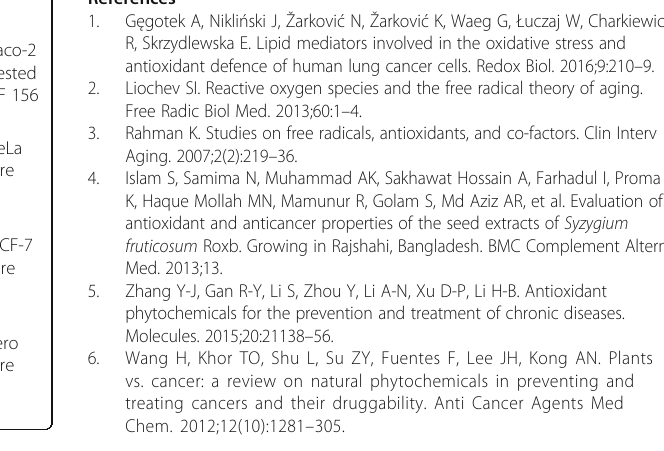
Additional file 1: Figure S1. Non-linear regression curves for IC 50 de- termination of different extracts from Croton species in 15-lipoxygenase (15-LOX) inhibitory assay. CSA and CSE represent respectively acetone, ethanol and water extracts of Croton sylvaticus. CGA and CGE represent respectively acetone, ethanol and water extracts of Croton gratissimus. CPA and CPE represent respectively acetone, ethanol and water extracts of Croton pseudopulchellus. (TIF 109 kb) Additional file 2: Figure S2. Concentration-dependent graph of A549 cell viability of different extracts from Croton species . Extracts were tested at concentrations between 200 and 6.25 μ g/mL; Ctrl: 0.5% DMSO. (TIF 128 kb) Additional file 3: Figure S3. Concentration-dependent graph of Caco-2 cell viability of different extracts from Croton species . Extracts were tested at concentrations between 200 and 6.25 μ g/mL; Ctrl: 0.5% DMSO. (TIF 156 kb) Additional file 4: Figure S4. Concentration-dependent graph of HeLa cell viability of different extracts from Croton species. Extracts were tested at concentrations between 200 and 6.25 μ g/mL; Ctrl: 0.5% DMSO. (TIF 142 kb) Additional file 5: Figure S5. Concentration-dependent graph of MCF-7 cell viability of different extracts from Croton species . Extracts were tested at concentrations between 200 and 6.25 μ g/mL; Ctrl: 0.5% DMSO. (TIF 136 kb) Additional file 6: Figure S6. Concentration-dependent graph of Vero cell viability of different extracts from Croton species. Extracts were tested at concentrations between 1000 and 50 μ g/mL Ctrl: 0.5% DMSO. (TIF 132